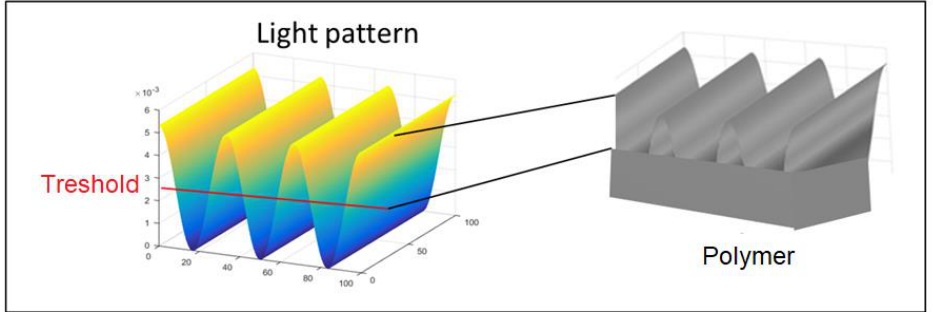
Figure 4. Transcription of an interference light pattern into a polymer pattern when the ablation occurs only at light intensities above a threshold.